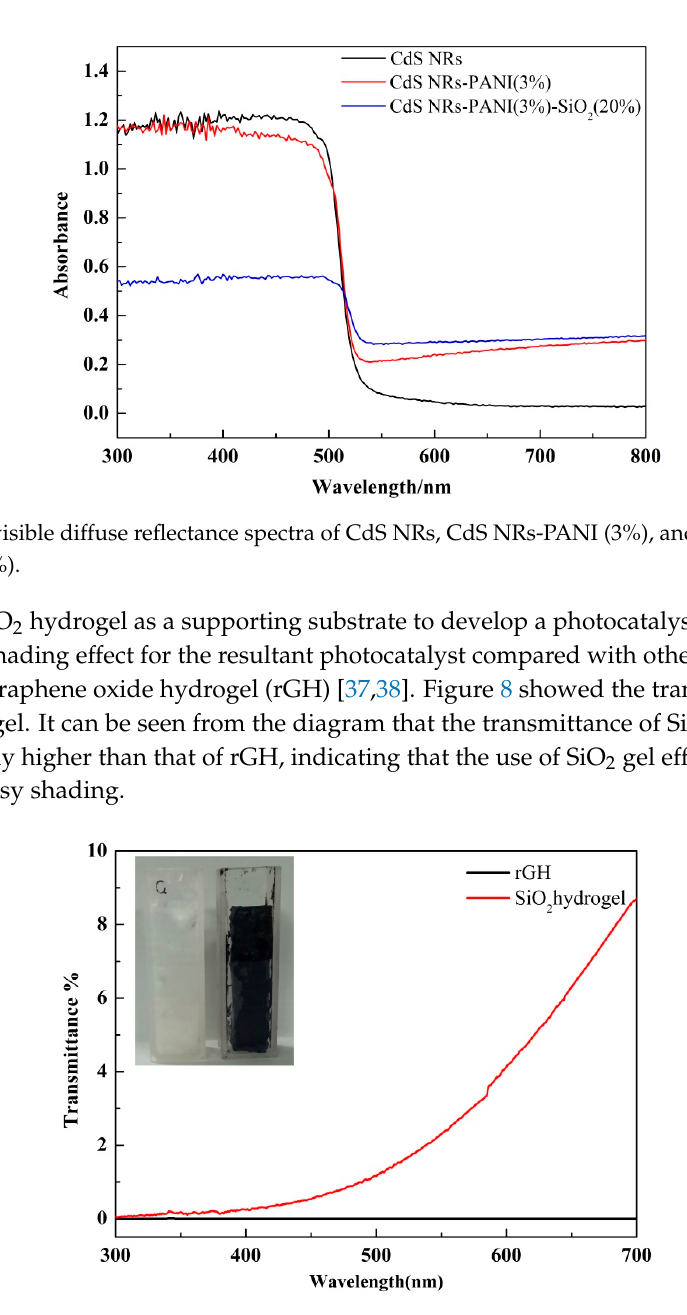
Figure 8. Light transmittance of SiO 2 hydrogel and rGH.